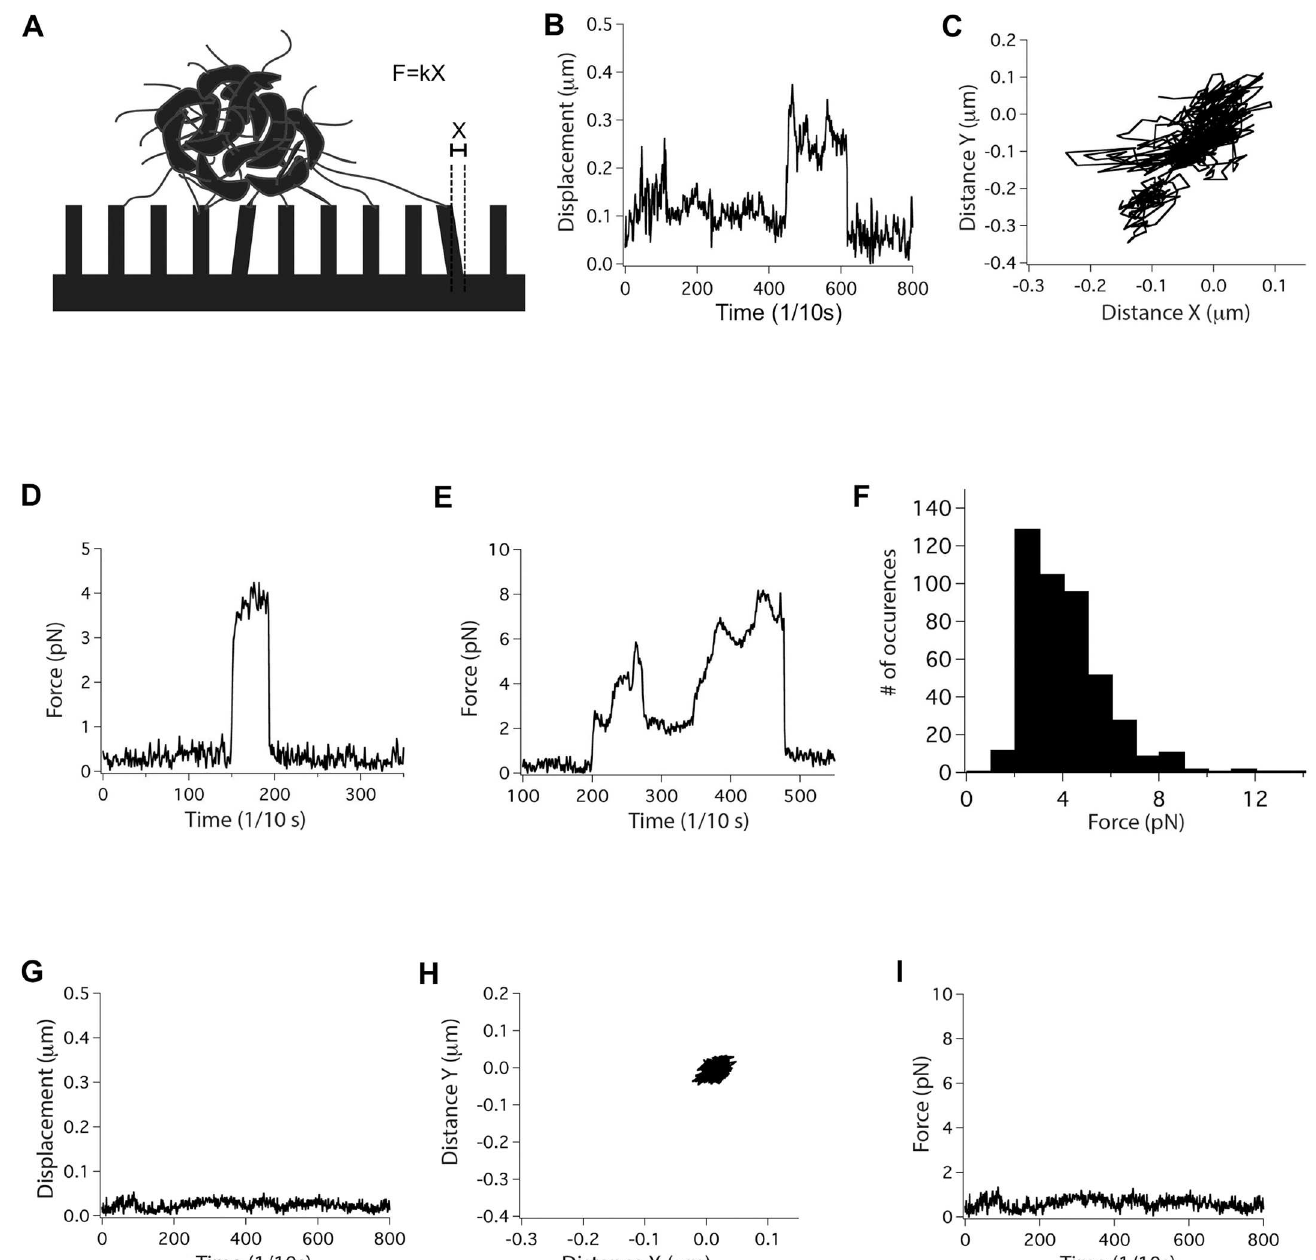
Fig 5. Micropillars assay demonstrates that TCP are retractile. (A) Illustration of the micropillars assay set-up. The force of retraction, F , is the product of the springconstant of the micropillars, k (here k = 25 pN/ μ m), and the displacement of a micropillar from its resting position, X . (B-F) Data plots from micropillarsassays for V . cholerae Δ flaA . (B) Displacement of a single micropillarunder a bacterial aggregateover time, measuredfrom its resting position.The displacement is representative of hundredsof micropillars motions analyzedfor several hours of recordings. (C) Projectionin X and Y of the movement of the micropillars shown in (B) over the same period of time. (D, E) Representative values for force exerted on a single micropillaras a function of time for two separate retraction events. (F) Histogram of the force distributionfor recordedTCP retraction events for V . cholerae Δ flaA . (G-I) Representative results for V . cholerae Δ tcpB / Δ flaA showing (G) the displacement of a single micropillar over time, which is not detected above noise level, (H) the projection in X and Y of the movement of the micropillarsshownin (G), and (I) the calculatedforce exerted on the same micropillarover the same periodof